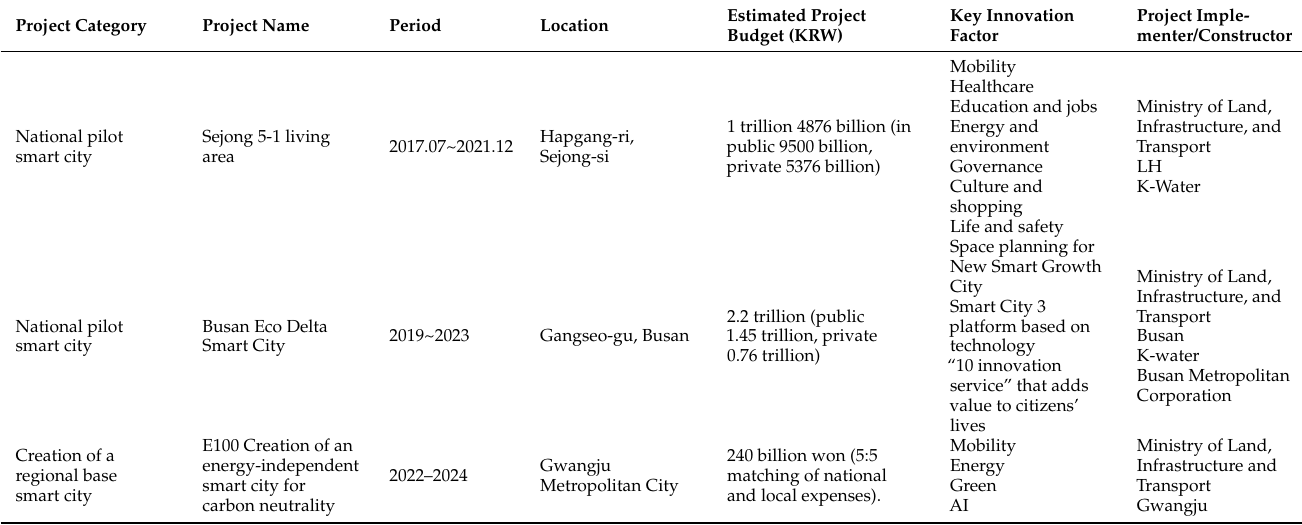
Table A1. Smart city projects in South Korea, 2017–2022 (with forecast until